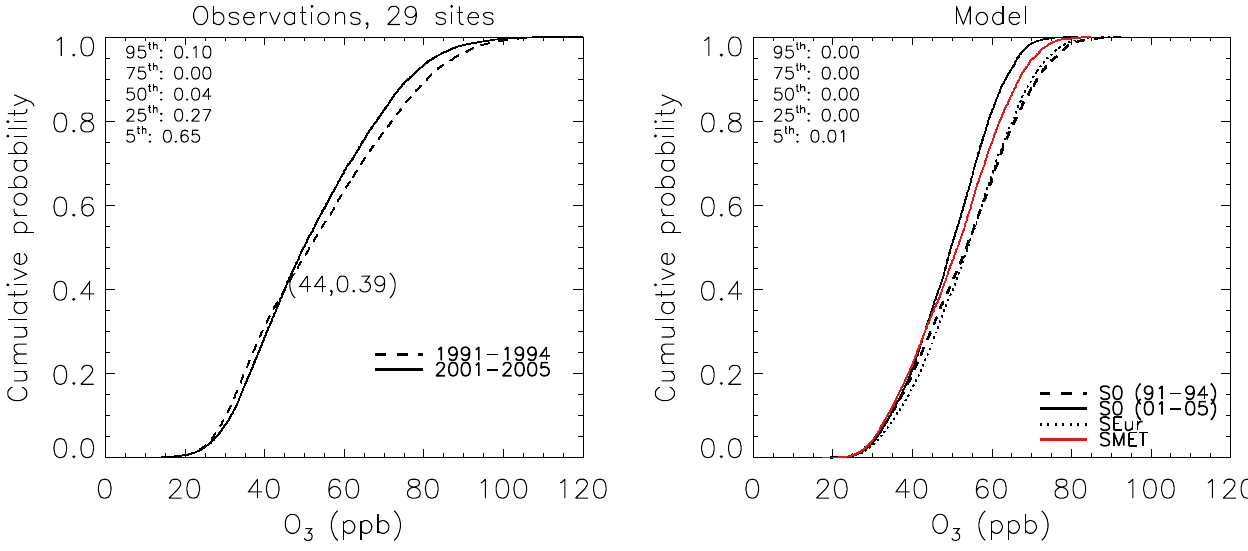
Fig. 5. Cumulative probability distribution of the 8-h daily maximum summertime (JJA) O 3 concentrations at rural sites in Europe in 1991– 1994 (dashed line) and 2001–2005 (solid line). We exclude the anomalous hot year 2003 and also the sites with titration effects (see Sect. 4.1.1 for details). The statistical significance level between the two distributions (1991–1994 vs. 2001–2005) is indicated for 5 percentiles in the upper left corner of each panel. The sensitivity simulations “SEur” (dotted line) and “SMet” (red line) are significantly different from ”S0”.